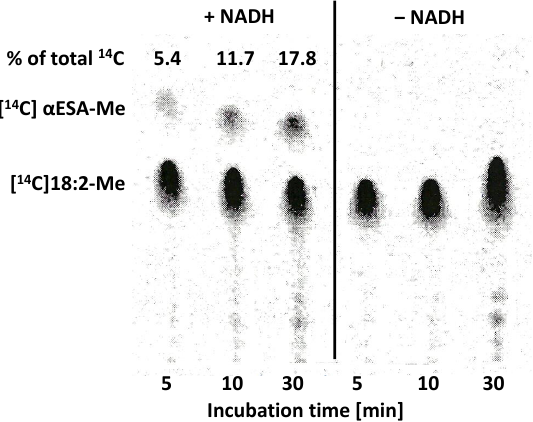
Figure 6. Biosynthesis of [ 14 C]αESA by microsomal fraction of developing seeds of Momordica charantia from exogenous [ 14 C]18:2-CoA in the presence and absence of NADH. % of total 14 C = percentage of [ 14 C]αESA (mean values from duplicates). Assay conditions: 10 nmol [ 14 C]18:2-CoA, BSA (4 mg/mL), NADH (4 mM in assays with NADH); aliquots of microsomal fractions: 24 nmol endogenous PC.